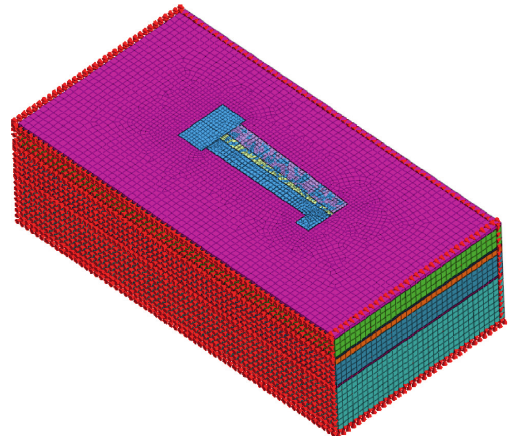
Figure 11: Boundary condition diagram of the